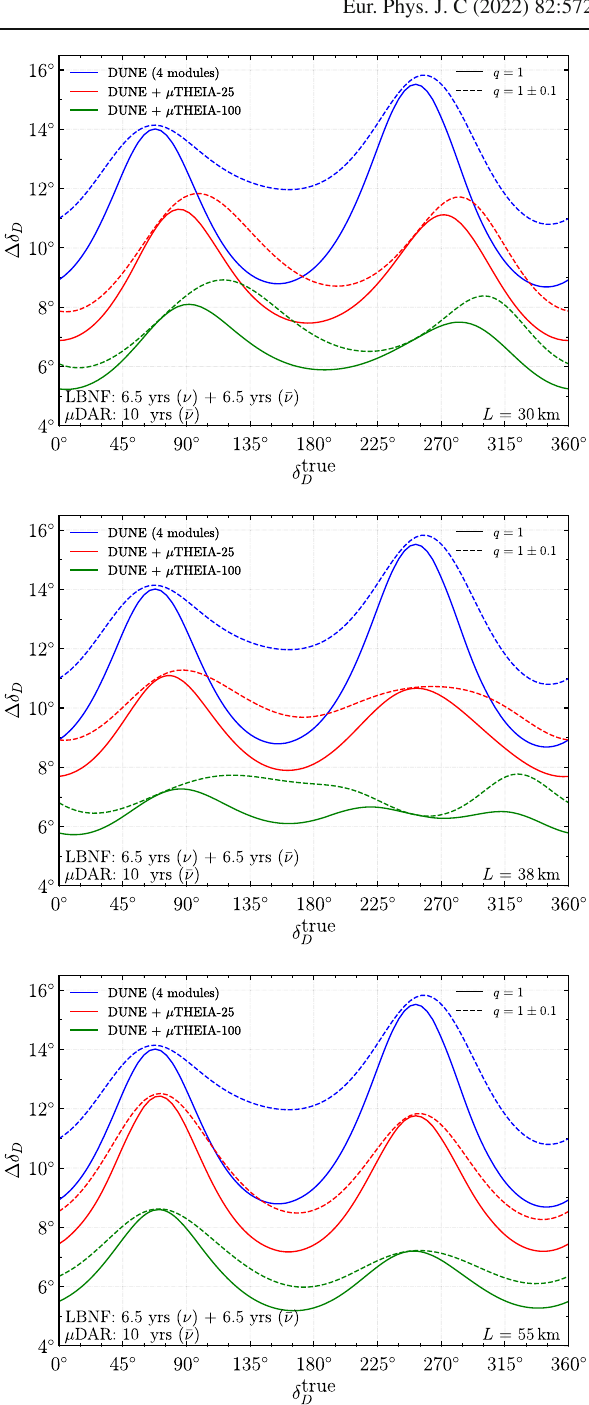
Fig. 14 The CP phase uncertainty (cid:8)δ D as a function of the true CP value δ true . For illustration, the three μ THEIA baseline options D L = 30km (top), 38km (middle), and 55km (bottom) are shown sep- arately. Each panel takes three different experimental setups, DUNE with 4 modules (blue), DUNE with 3 modules and μ THEIA-25 (red) or μ THEIA-100 (green). As for the matter effect, both the fixed case ( q = 1, solid) and 10% uncertainty ( q = 1 ± 0 . 1, dashed) are imple- mented to show how it affects the CP